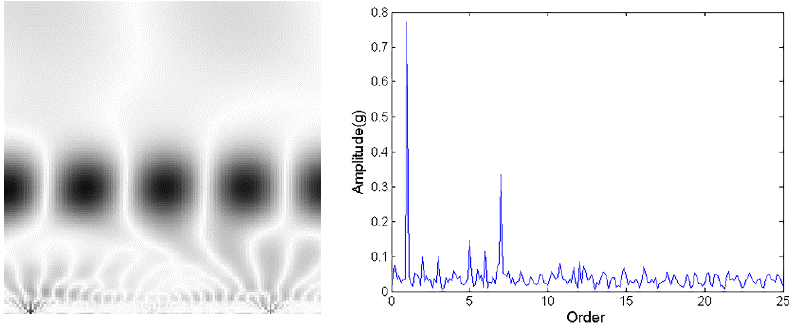
Figure 11. CWTS and spectrum of the contact rubbing test data.